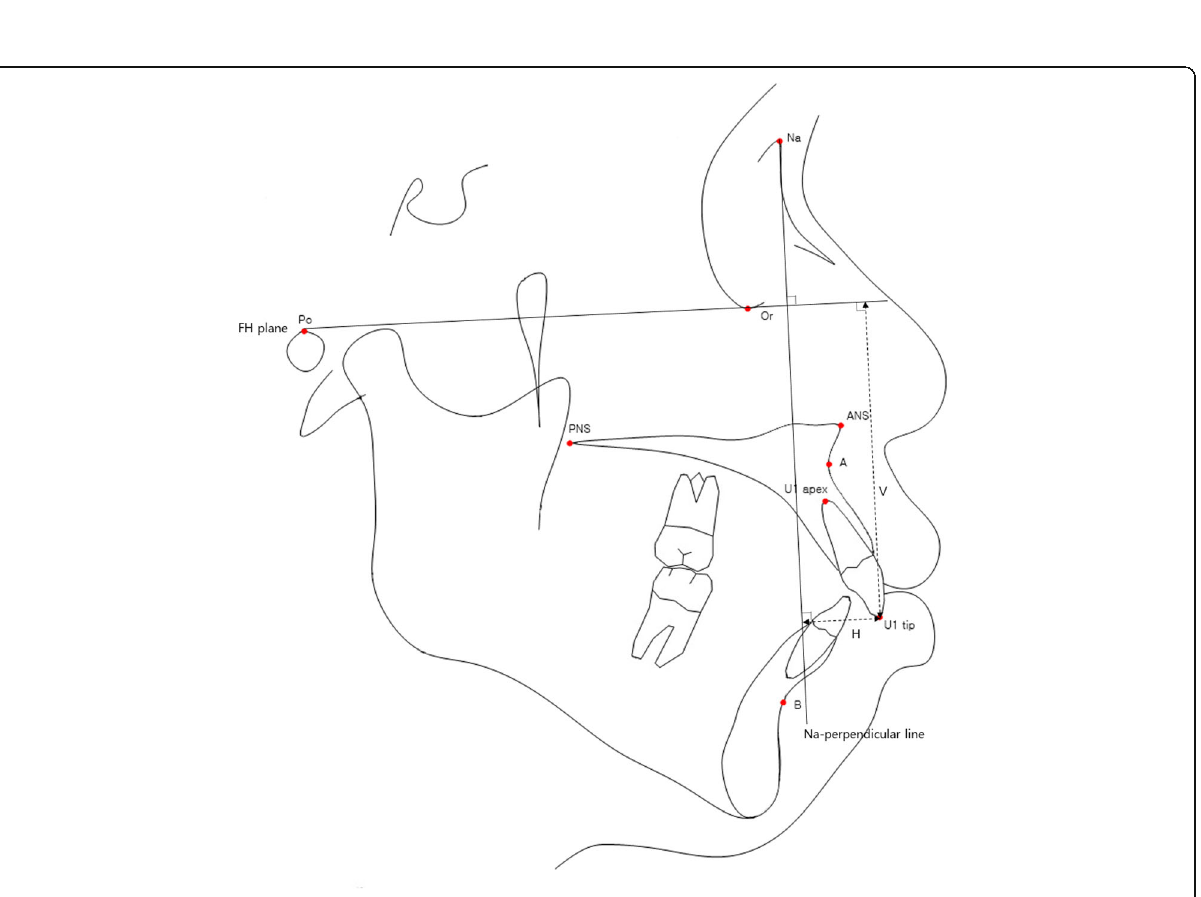
Fig. 2 Reference lines used to determine the extent of intrusion and retraction of the incisor. Difference in the distance from incisor tip to Frankfort plane at pre-treatment and post-treatment (V0 – V1) represents the amount of intrusion of incisor. Difference in the distance from incisor tip to N-perpendicular line at pretreatment and posttreatment (H0 – H1) represents the amount of retraction of